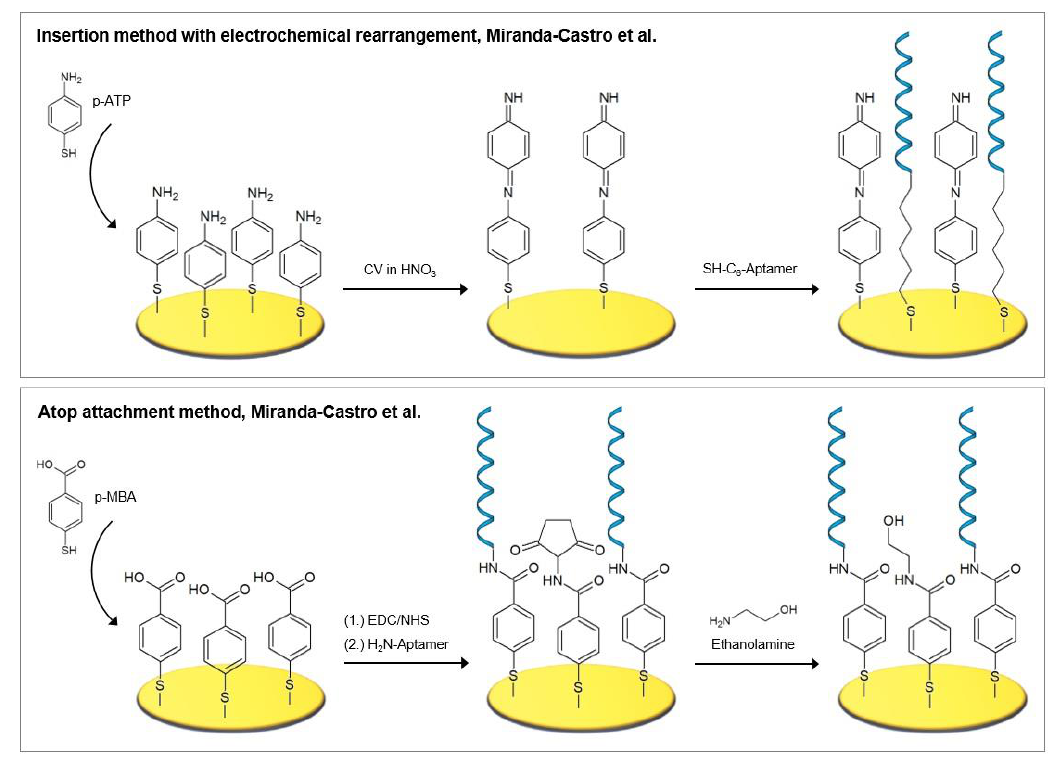
Figure 6. The most successful strategies based on thioaromatic monolayer formation investigated by Miranda-Castro et al. [53]. Miranda-Castro et al.